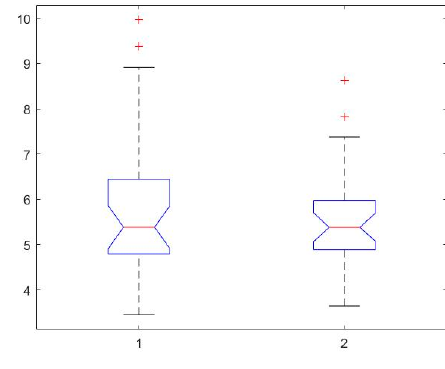
Figure 19. ANOVA test, MAPE indicator.